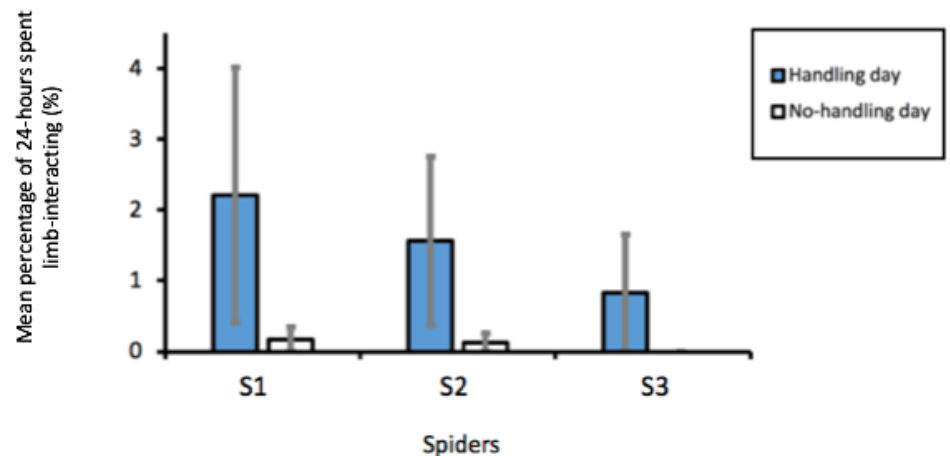
Figure 2. Mean ± SE percentage (%) of handling days (H) and no-handling days (NH) that S1 (8H, 6NH), S2 (6H, 8NH) and S3 (4H, 2NH) spent exhibiting limb-interaction behaviour.